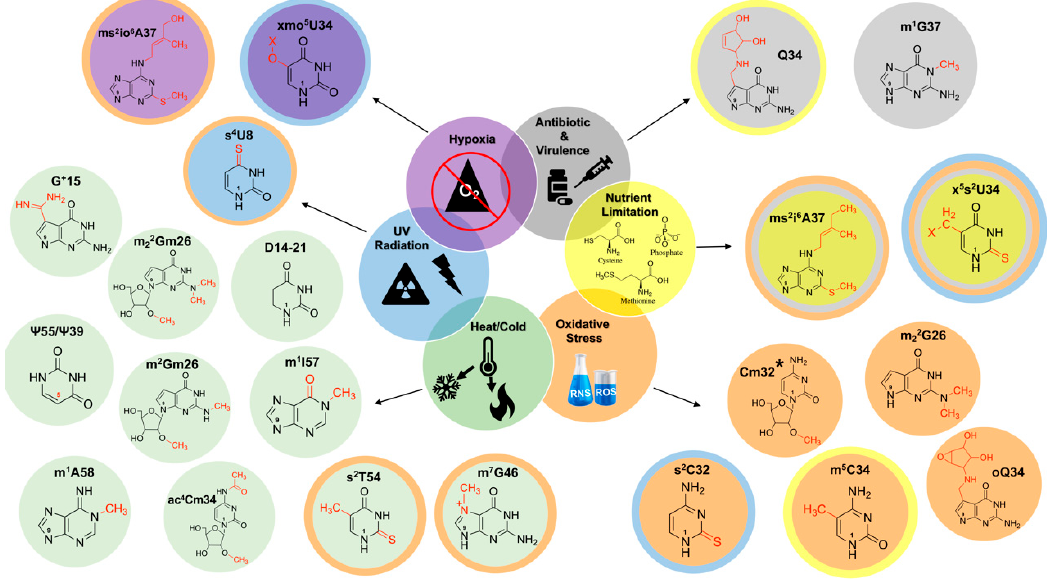
Figure 3. Schematic representation of tRNA modifications affected by nutritional and environmental stressors. The description of these factors, their associated modifications along with references are also noted in Table S1. Modifications affected by more than one condition are indicated with corresponding colored rings. *2-O’-methyladenosine (Am32) and 2-O’-methyluridine (Um32) are additionally affected by oxidative stress. The numbers “1” and “9” found within each base denote the β -glycosidic bond orientation found in the pyrimidine and purine bases, with their adjacent riboses in tRNA. The structure of the full nucleoside is only shown for modifications containing 2 ′ -O- methylation.